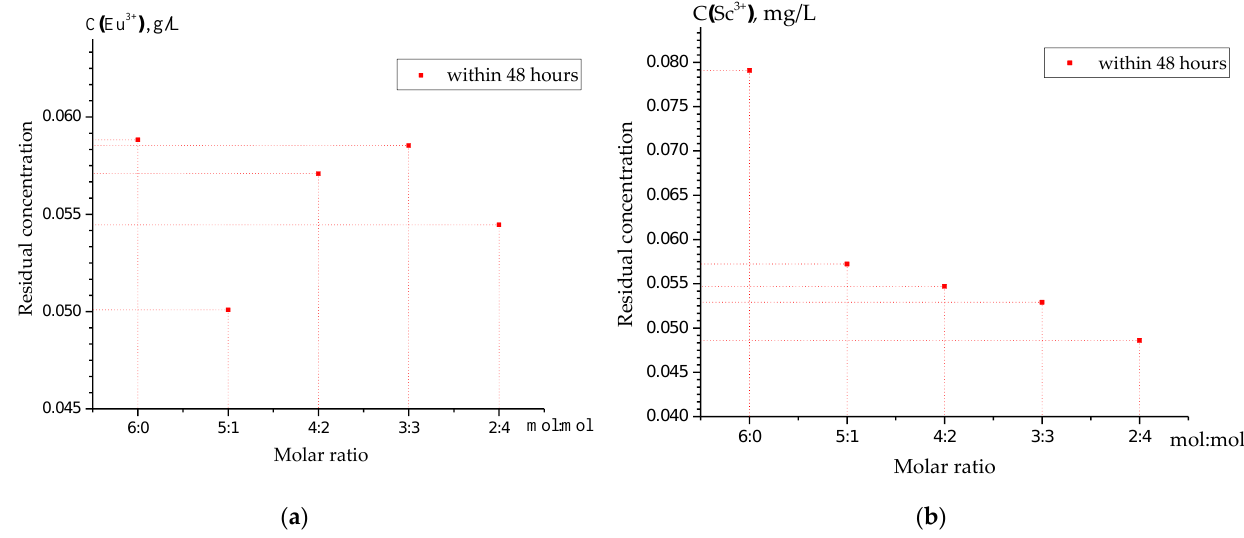
their nitrate solutions.